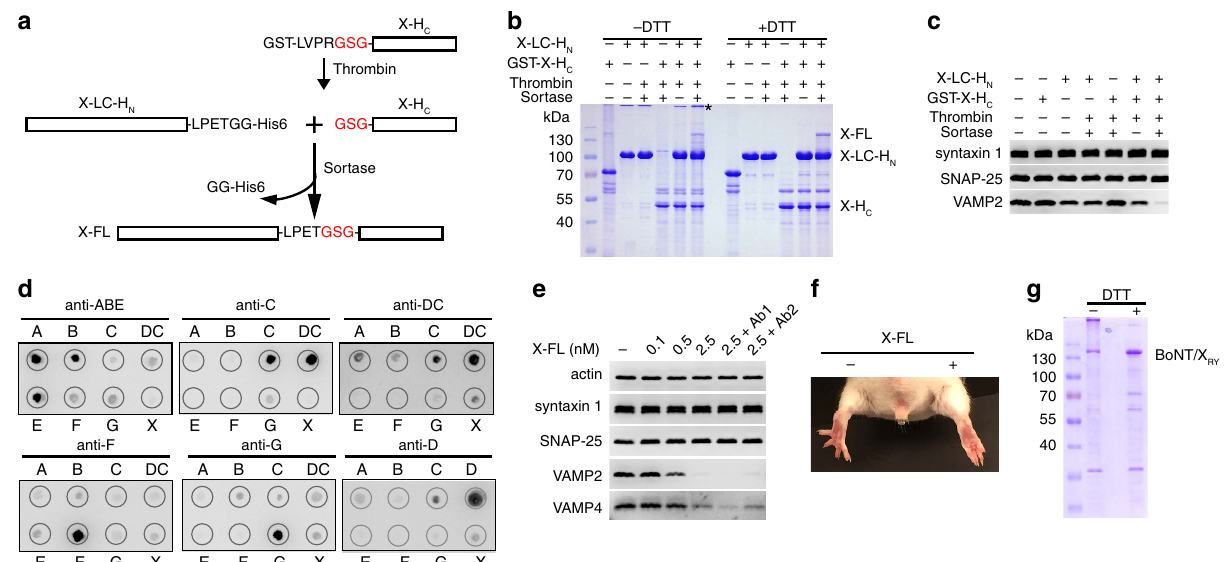
Figure 4 | Full-length BoNT/X is active on cultured neurons and in vivo in mice. ( a ) A schematic drawing of the sortase ligation method. ( b ) Sortase ligation reaction mixtures were analysed by SDS–PAGE and Coomassie Blue staining. The asterisk marks the proteins aggregates due to inter-molecular disulfide bonds. Full-length BoNT/X (X-FL) appeared only in the sortase ligation mixture. ( c ) Neurons exposed to the sortase ligation mixture (15 m l) or control mixtures for 12h in culture medium. Cell lysates were analysed by immunoblot. The mixture containing both X-LC-H N and X-H C (but not sortase) cleaved slightly more VAMP2 than X-LC-H N alone. Ligating X-LC-H N and X-H C by sortase further enhanced cleavage of VAMP2, demonstrating that ligated X-FL is functional on neurons. ( d ) BoNT/A-G, BoNT/DC and BoNT/X were subjected to the dot blot assay, using four horse antisera (trivalent anti-BoNT/A, B and E, anti-BoNT/C, anti-BoNT/DC and anti-BoNT/F), as well as two goat antisera (anti-BoNT/G and anti-BoNT/D). BoNT/X is composed of X-LC-H N and X-H C at 1:1 molar ratio. These antisera recognized their corresponding target toxins, yet none recognized BoNT/X. The antisera against BoNT/DC and BoNT/C cross-react, as these two toxins share a high degree of similarity within their H C domains. ( e ) Cultured rat cortical neurons were exposed to ligated X-FL in culture medium for 12h, with or without two combinations of anti-sera. Ab1: trivalent anti-BoNT/A/B/E, anti-BoNT/C and anti-BoNT/F. Ab2: anti-BoNT/G and anti-BoNT/D. The trivalent anti-BoNT/A/B/E was used at 1:50 dilution. All other anti-sera were used at 1:100 dilution. None of the antisera affected the cleavage of VAMP2 and VAMP4 by X-FL. The specificity and potency of these antisera were validated for their ability to neutralize target serotypes in the same assay as described in Supplementary Fig. 7. ( f ) X-FL linked by sortase reaction (0.5 m g) was injected into the gastrocnemius muscles of the right hind limb of mice ( n ¼ 4). The injected limb developed typical flaccid paralysis, and the toes failed to spread within 12h. The left limb was not injected with toxins, serving as a control. ( g ) Full-length inactive form of BoNT/X (BoNT/X RY ) was purified as a His6-tagged recombinant protein in E. coli . Further purified BoNT/X RY is shown in Supplementary Fig. 8b. One of two ( e ) or three ( c , d ) independent experiments is